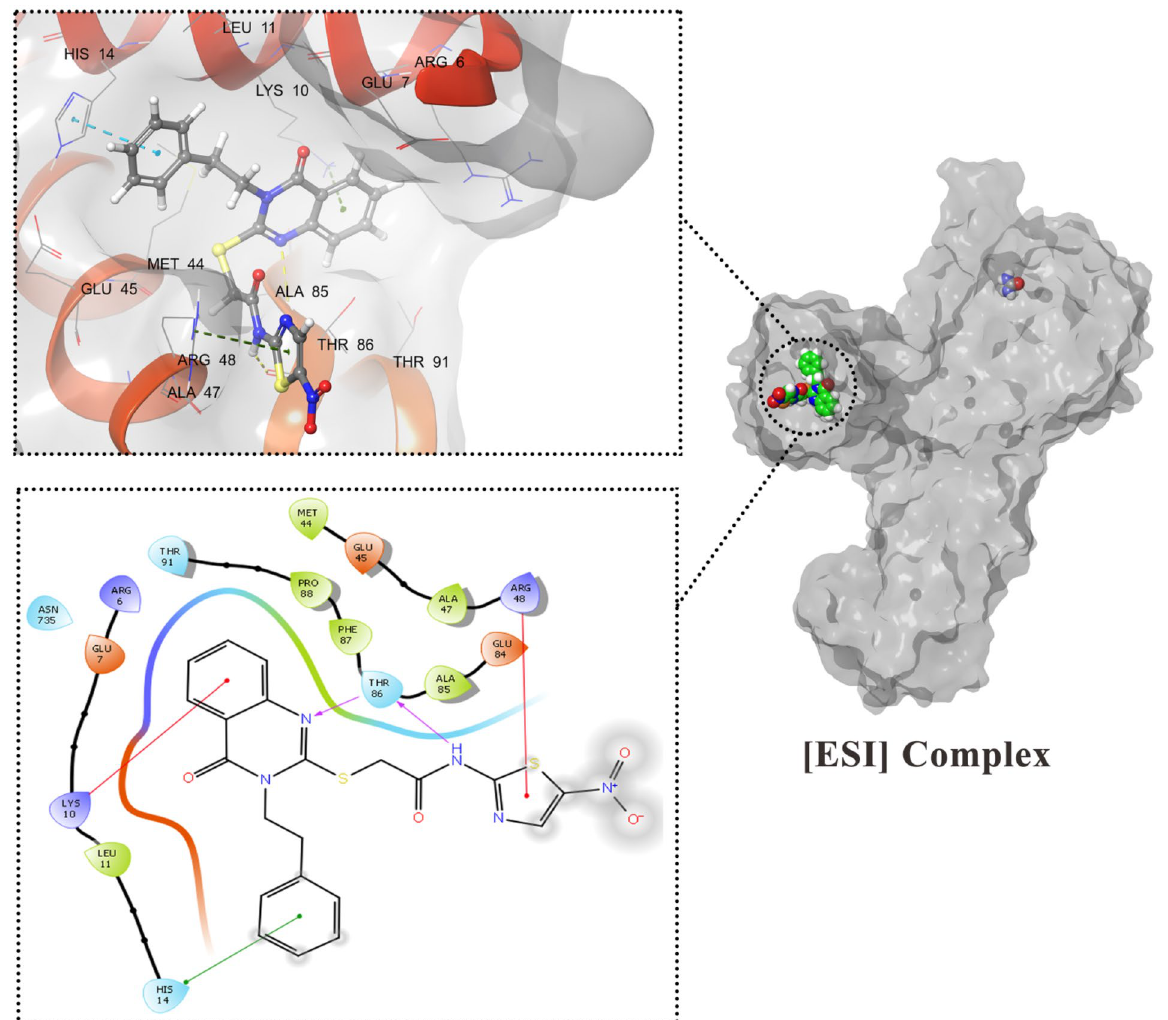
Figure 7. 3D and 2D interactions of compound 8h in the [ESI] complex.